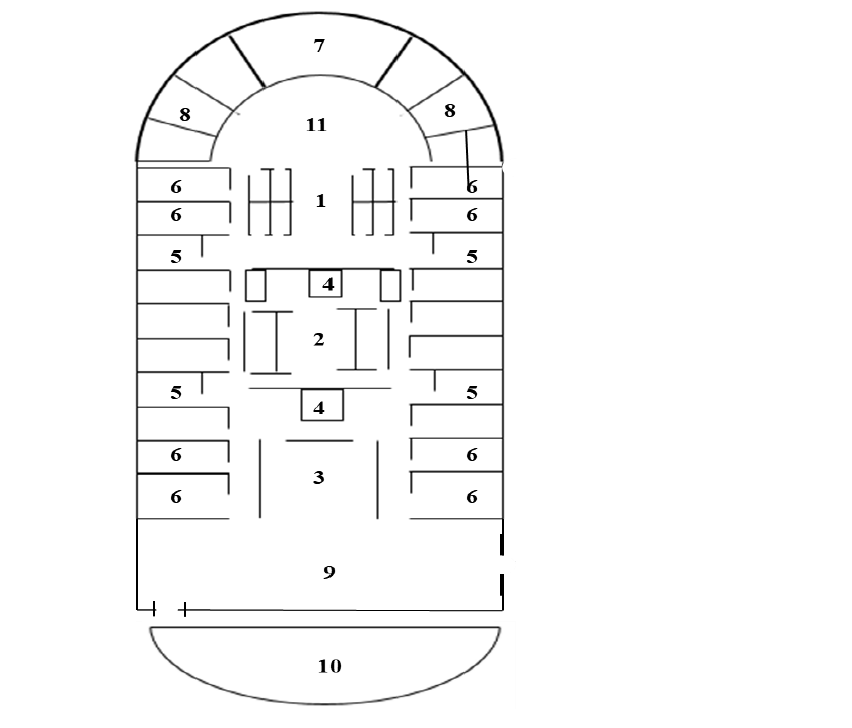
Figure 13. The interior of the Dragon House.